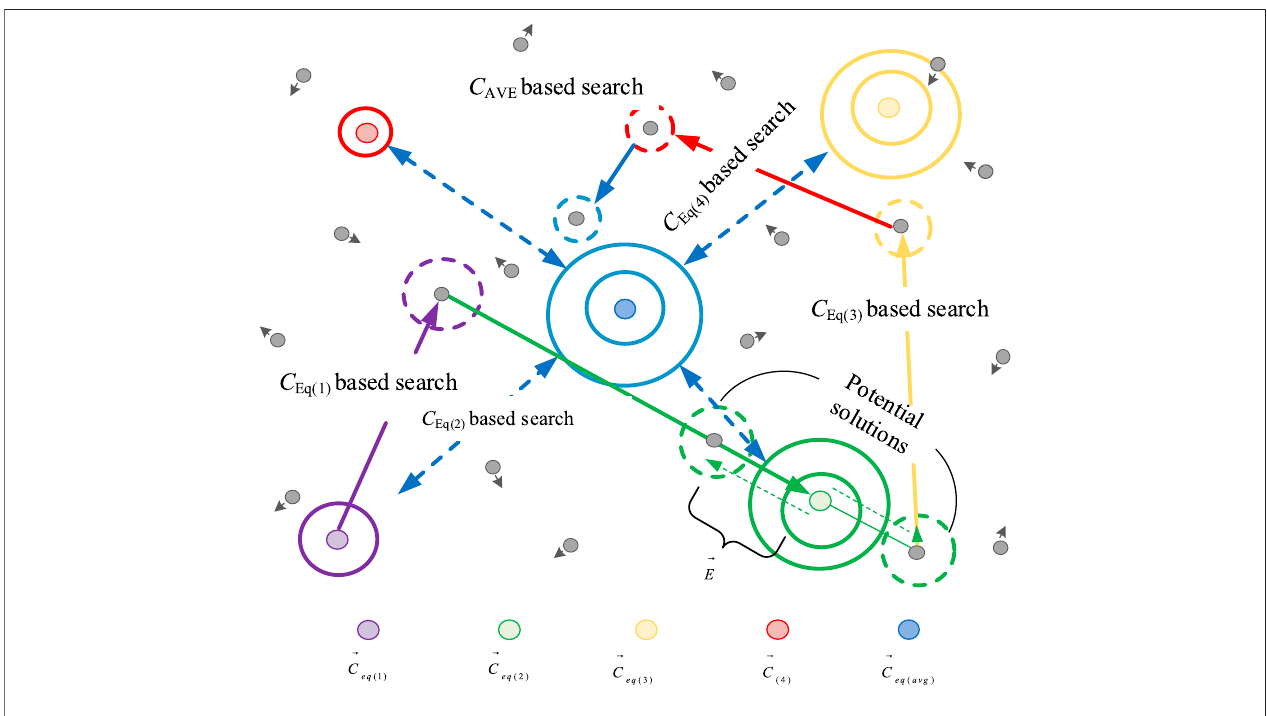
FIGURE 3 | Optimization schematic diagram of the EO algorithm.